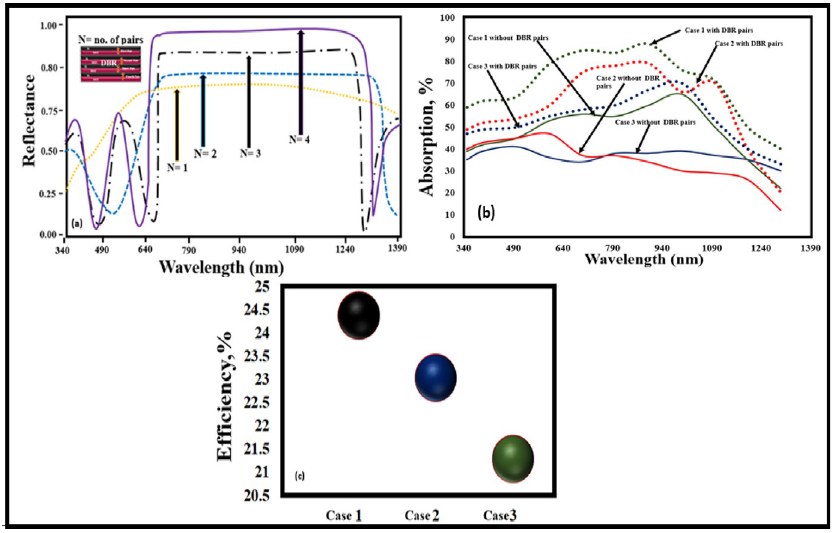
Fig 12. (a) Demonstration of Reflectance Vs Wavelength at optimized DBR pairs (b) Absorption coverage range of the proposed structures with and without DBR pairs (c) Optimized efficiency comparison of the proposed structures featured with DBR